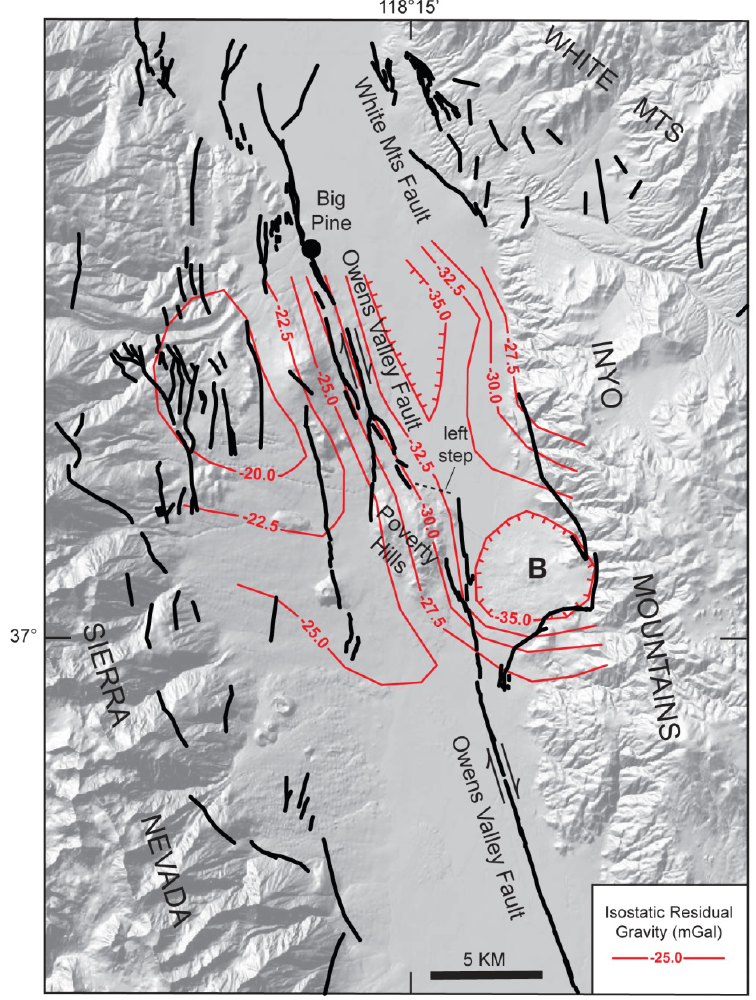
Figure 6. Map showing Quaternary faults in central Owens Valley and isostatic residual gravity contours in vicinity of the Poverty Hills [50,53]. Note left step in trace of Owens Valley Fault north of Poverty Hills and steep gravity gradient coincident with Poverty Hills. B = bight in northern Inyo